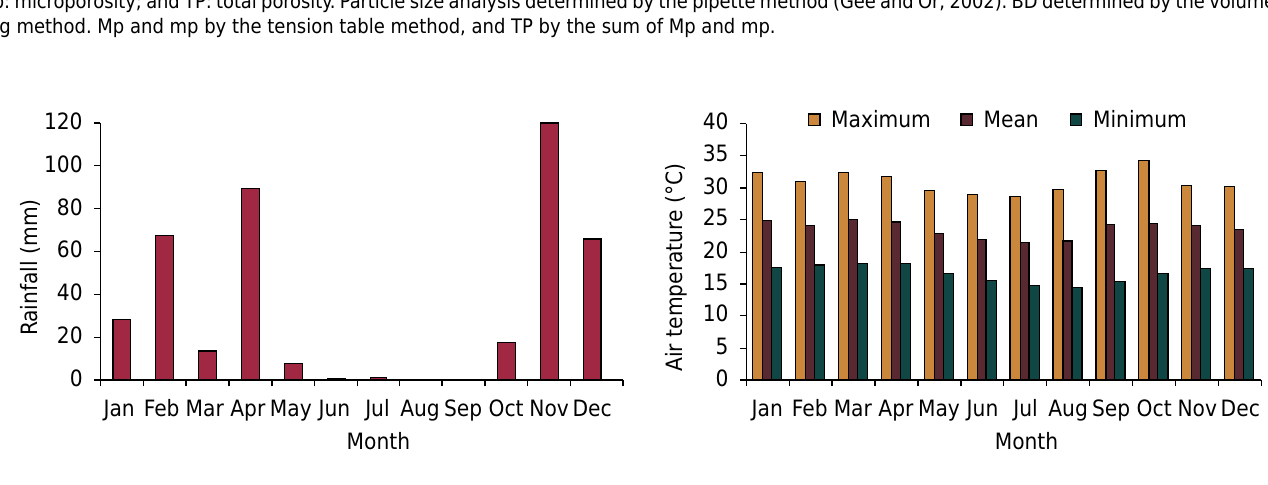
Figure 1. Monthly mean rainfall and maximum, medium, and minimum air temperature from February 04, 2014, to September 30, 2015, for Irecê Identity Territory, Bahia, Brazil, considering data of a single year for January, November, and December, and an mean of two years for other months. Source: Inmet